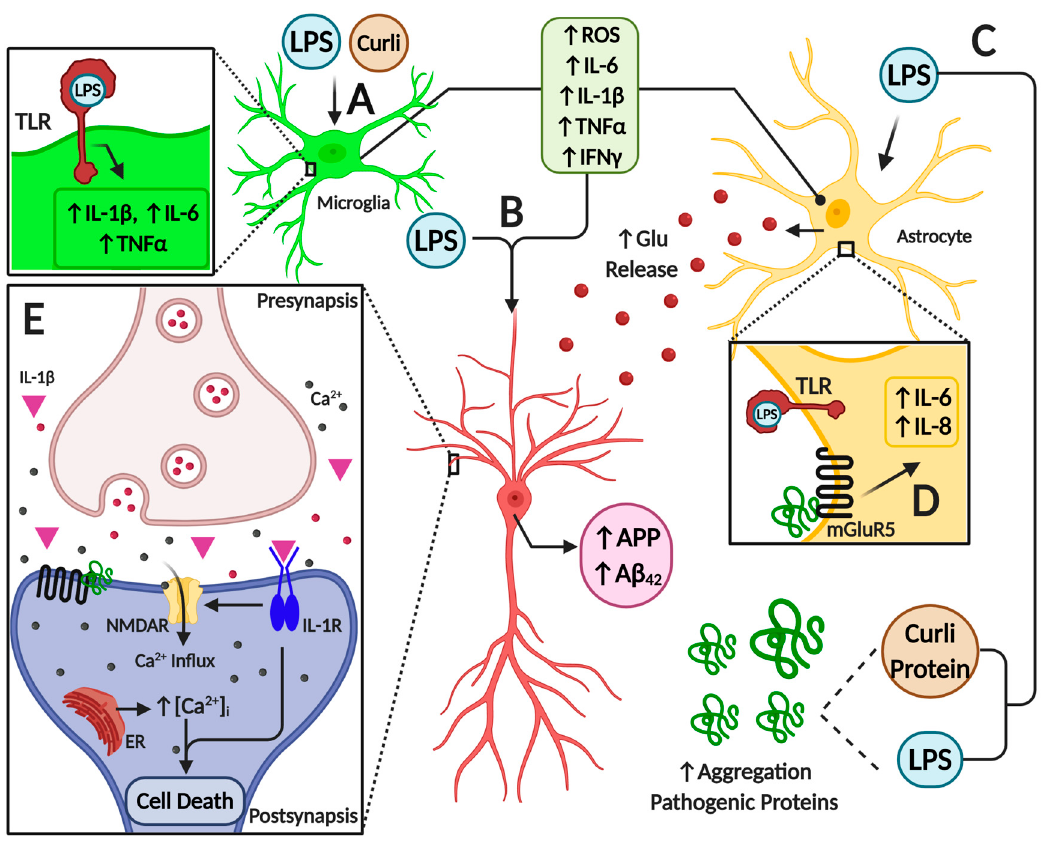
Figure 3. Illustration of neuroinflammatory mechanisms mediated by microbiome-derived products in nervous tissue. ( A ) Toll-like receptors (TLRs) expressed in glial cells are activated by LPS, triggering the activation of astrocytes and microglial cells. This activation induces an inflammatory response by overexpression and release of pro-inflammatory cytokines such as IL-6, IL-1 β , TNF- α and IFN- γ , and by an increase in oxidative stress due to the generation of reactive oxygen species. Furthermore, bacterial amyloid proteins (curli) activate glial cells and induce the expression of pro-inflammatory mediators. ( B ) Pro-inflammatory mediators, together with LPS, increase the expression of the amyloid precursor protein (APP), and the deposition and misfolding of A β peptide. ( C ) Both LPS and curli are able to increase the deposition and aggregation of pathogenic proteins. ( D ) In astrocytes, among other cell types, activation of mGlurR5 receptor by pathogenic proteins triggers the overexpression of pro-inflammatory cytokines such as IL-6 and IL-8, which worsen the inflammatory milieu in the brain. Moreover, a high level of pro-inflammatory mediators leads to increased levels of the neurotransmitter glutamate, furthering ionic dyshomeostasis and augmenting neuronal excitotoxicity. ( E ) Finally, mGluR5 activation by pathogenic proteins induces the release of calcium from the endoplasmic reticulum, leading to ionic and mitochondrial dyshomeostasis, which results in neuron death. Furthermore, the activation of IL-1R in neurons by the binding of IL-1 β cytokine amplifies the activity of NMDARs and mediates the inflammatory response via p38 MAPK. Overall, these alterations stimulate endoplasmic reticulum (ER) Ca 2+ release through ryanodine receptors and IP3 receptors, which trigger ER stress and mitochondrial fragmentation leading to synaptic failure and neuronal apoptosis.